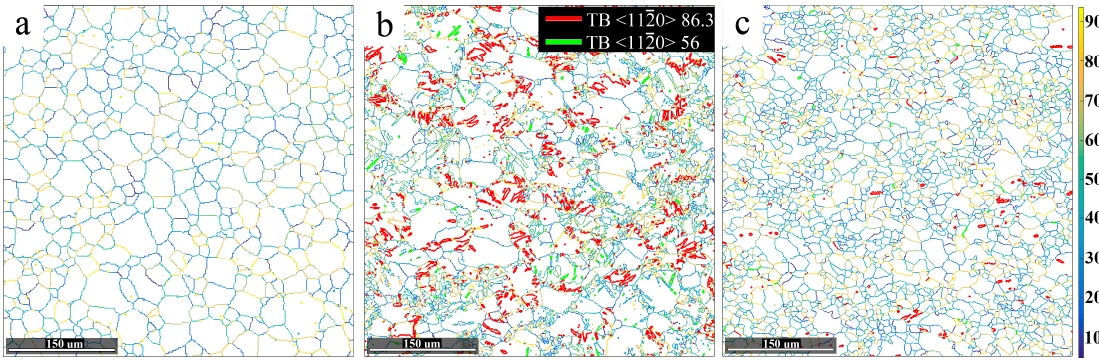
Table 1. Grain-boundaries’ misorientation, area fraction of < 112(cid:3364)0 > tension and compression